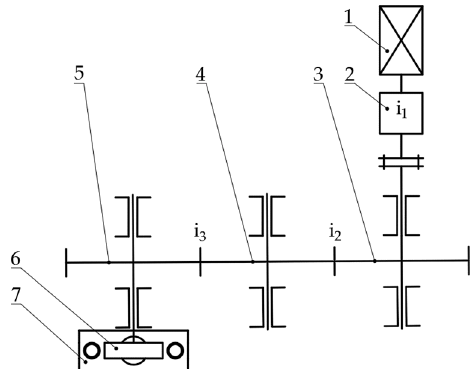
Figure 12. Kinematic diagram for the drive system of the stamp–sleeve compacting unit assembly, where: 1—electrical motor, 2—reduction gearbox, 3—gear wheel 1, 4—gear wheel 2, 5—gear wheel 3, 6—cam, 7—stamp–sleeve compacting unit with guides and pressure springs and i 1 —gear ratio of the gearbox connected directly to the motor.